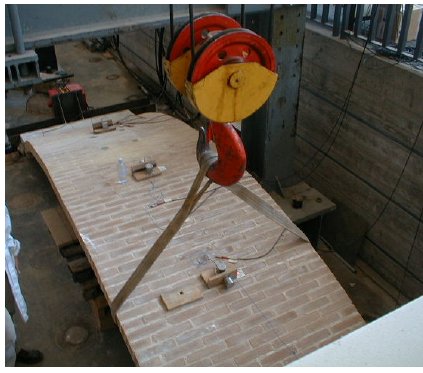
Figure 6. Raising of the vault to allow free vibrations.